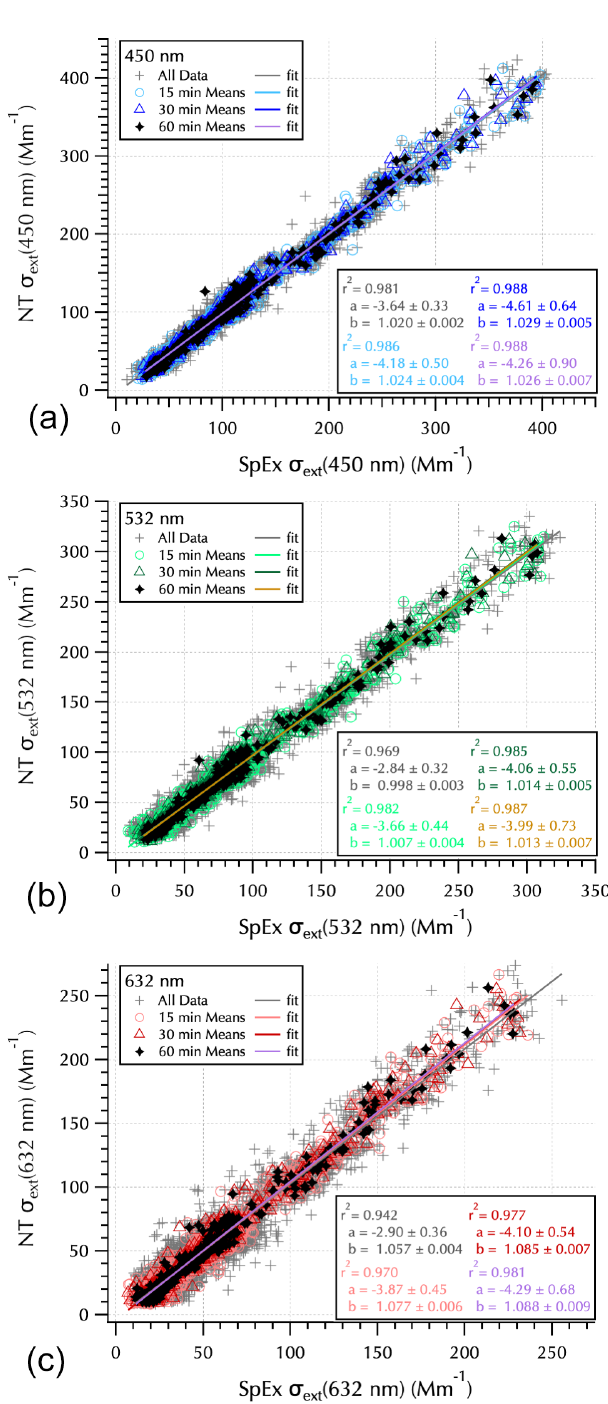
Figure 3. NT vs. SpEx σ ext (450nm, a ; 532nm, b ; 632nm, c ). All data points (gray pluses) are shown with 15min (light colored cir- cles), 30min (dark colored triangles), and 60min (black symbols) means. Fit lines, coefficients, and r 2 values are color-coordinated with the symbols, except for the black markers where the fit lines used a light color for visibility. Above LLOD points